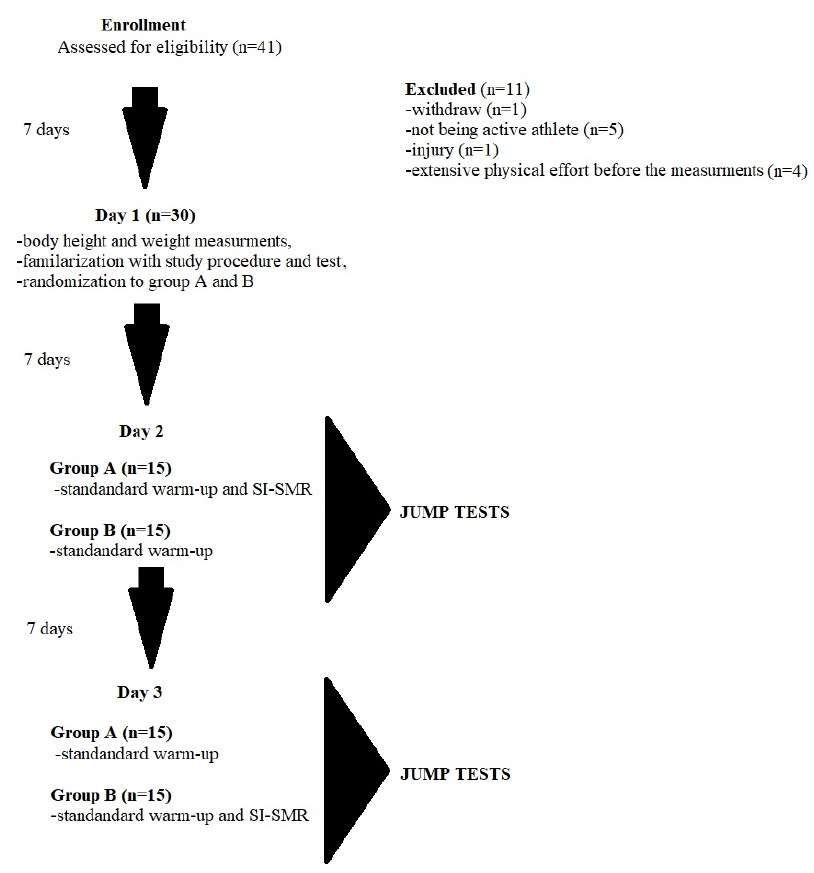
Figure 1. The study